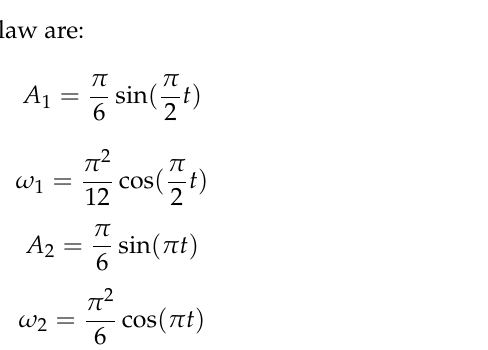
Figure 13. Two Motion Laws of Transient Maneuver.